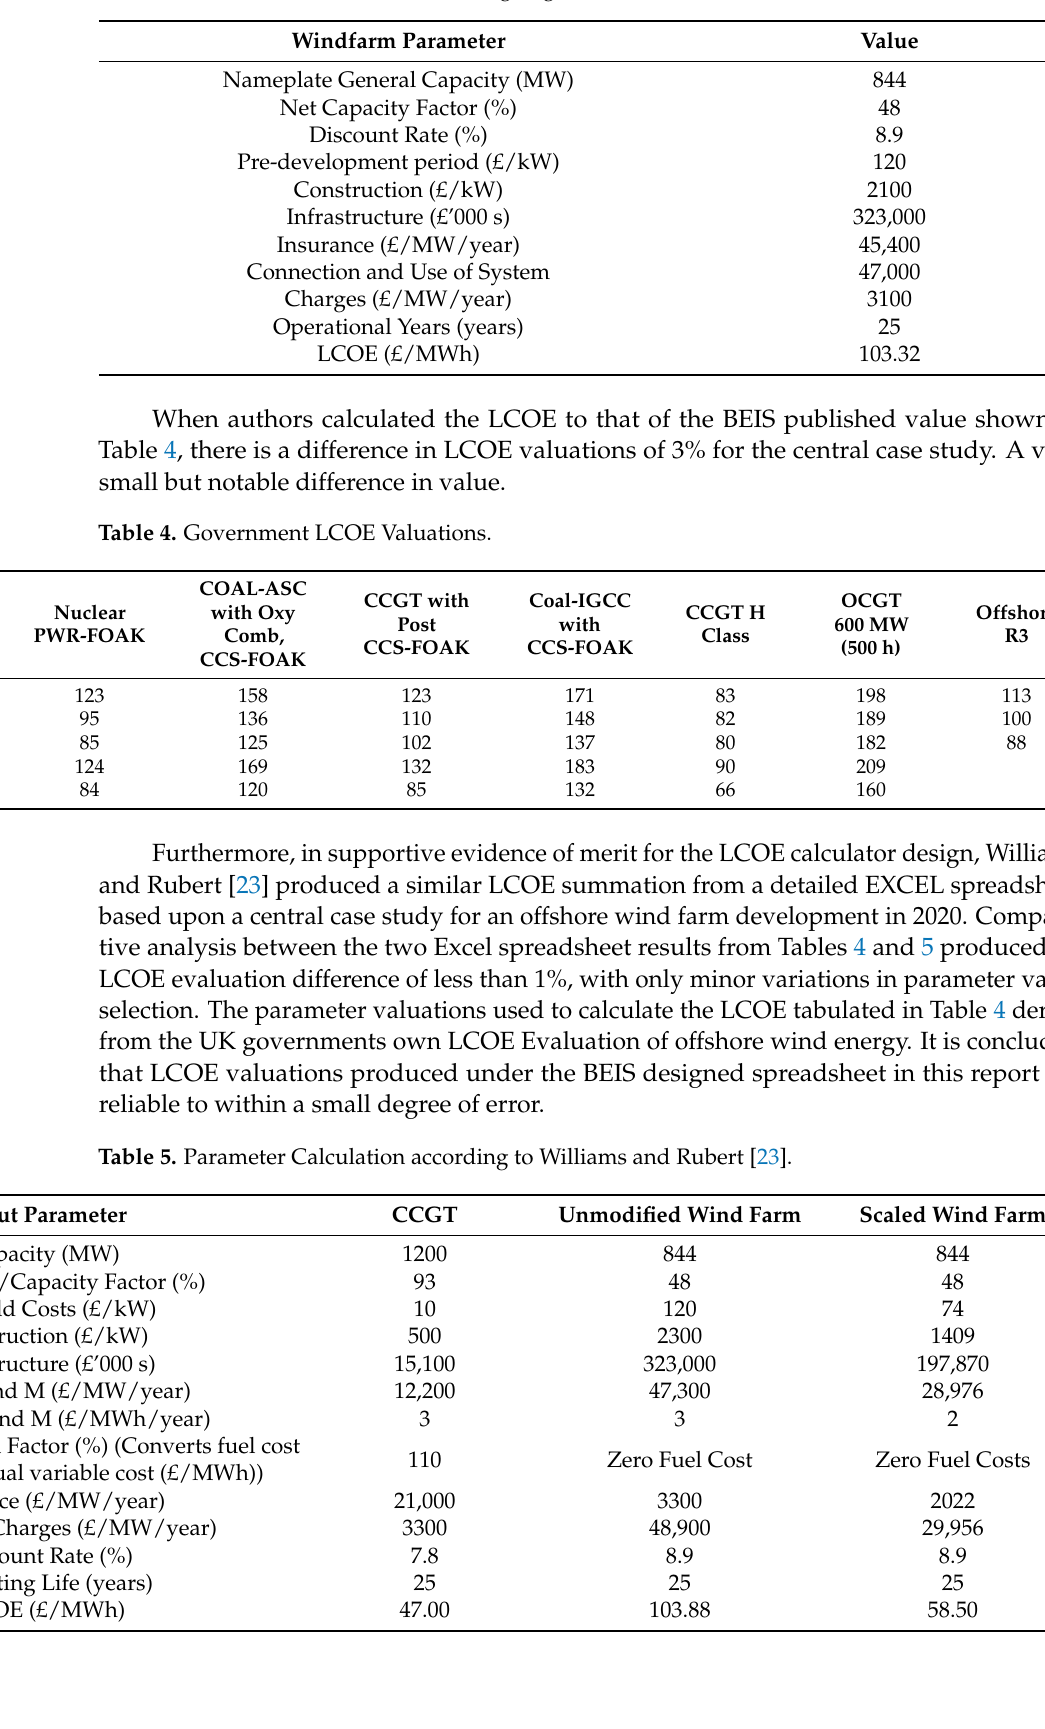
Table 3. Parameter calculations according to government scenario.